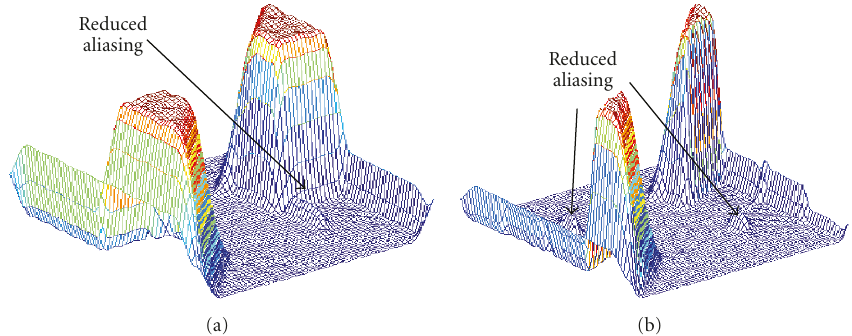
Figure 17: Examples of directional filters in the PDFB (a) (cid:16) H 1 ( ω 1 , ω 2 ) of a four-band PDFB and (b) a directional filter of an eight-band